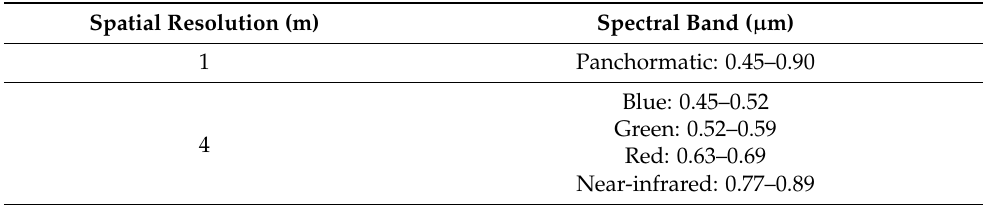
Table 2. Spectral information of GF-2 PMS.